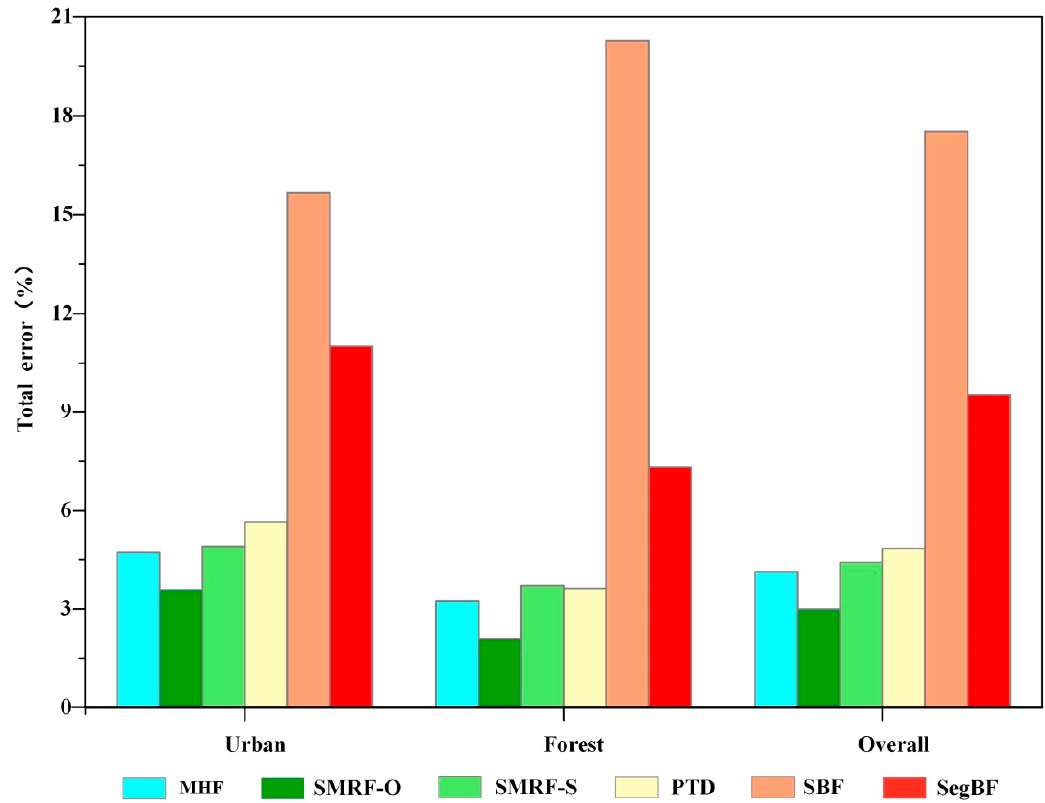
Figure 13. Average total errors of all the filtering algorithms on urban (samp11–42), forest (samp51–71) and overall samples of the ISPRS benchmark datasets. SMRF-O and SMRF-S represents SMRF with the optimized parameters for each sample, and SMRF with one single parameter for the 15 samples, respectively.